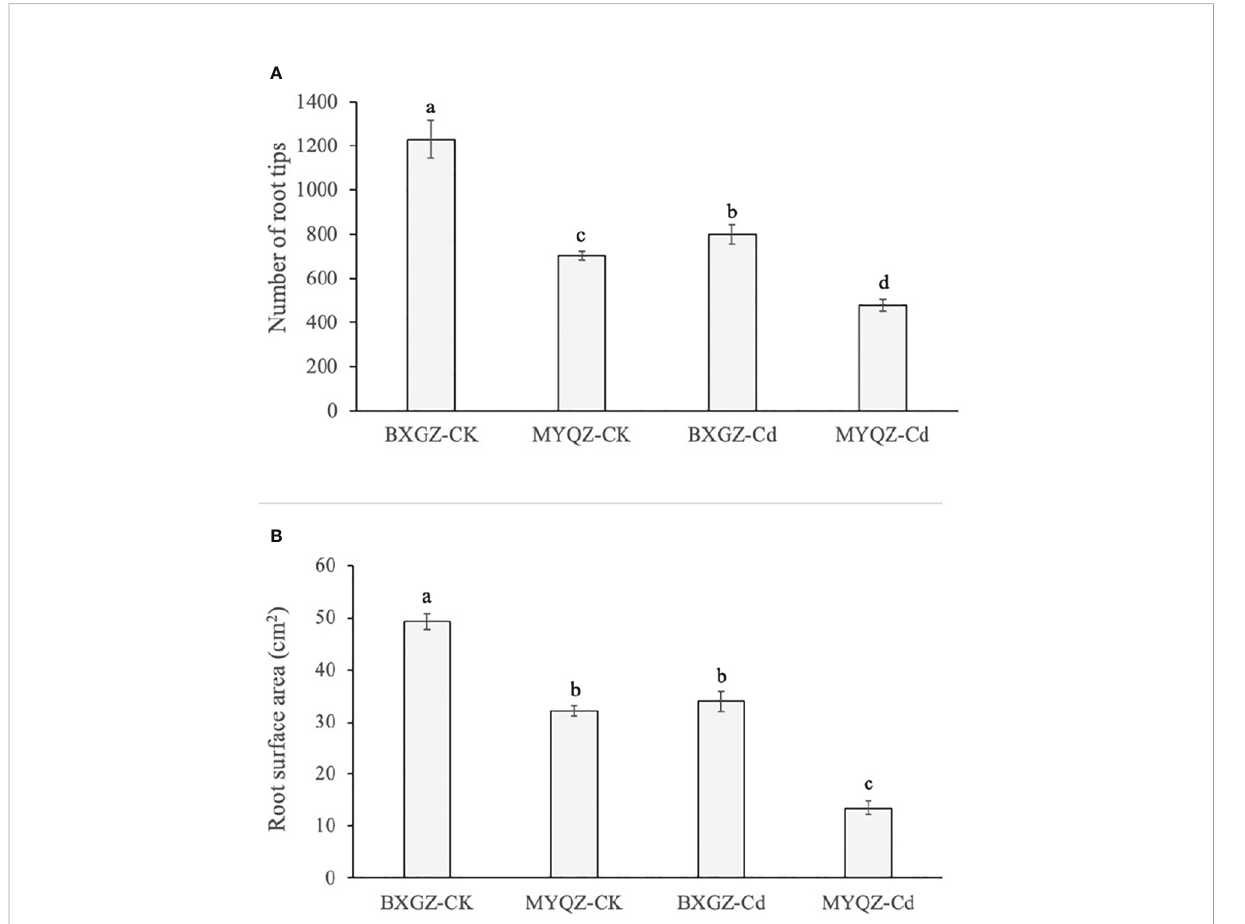
FIGURE 5 The root tips (A) and surface area of (B) BXGZ and MYQZ under different treatments. Values are the mean ± standard error (n = 3). Different small letters indicate signi fi cant differences ( p < 0.05) among the four